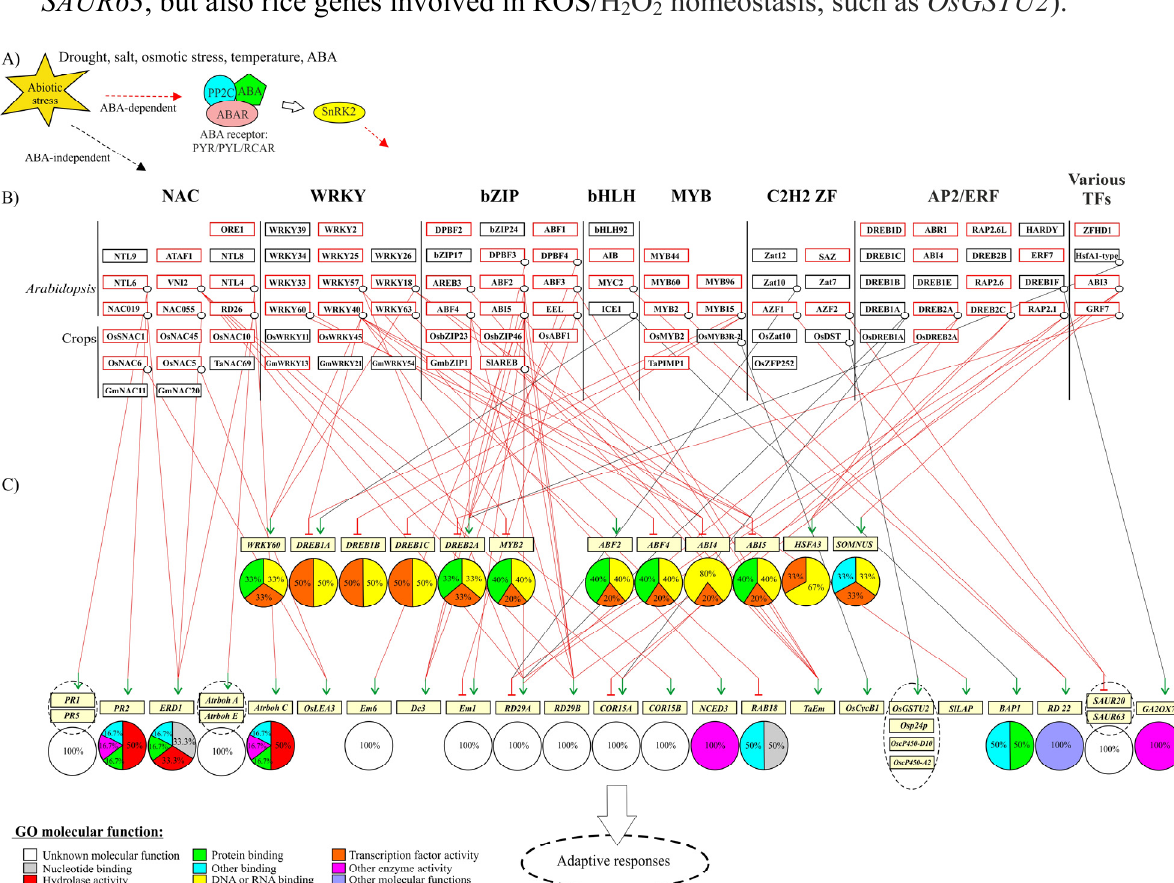
(Figure 1A), TFs known to function in abiotic stress responses (black boxes and lines) and/or ABA-associated signaling (red boxes and lines) (Figure 1B), and their direct target genes (Figure 1C). Figure 1. Gene regulatory networks of plant transcription factors (TFs) in plant abiotic stress responses and abscisic acid-dependent gene expression. ( A ) Drought, salt, osmotic stress, temperature, and ABA stress factors modulating the level and activity of the TF ( B ) and their target genes ( C ). ABA-dependent signaling pathway can involve TF phosphorylation through the PYR/PYL/RCAR ABA receptor [15]. ( B ) The boxes represent TF proteins from the model plant Arabidopsis or from different crop plants. Red boxes and lines show that the TF is associated with ABA-signaling. For TF and target genes with several names only one of the names is shown. For references and abbreviations used see the main text. ( C ) The direct target genes are divided into regulatory genes including TF genes and stress-responsive genes encoding functional proteins. The Gene Ontology (GO) molecular function term is shown as a circle with color code below each Arabidopsis target gene. The GO molecular function annotation was obtained using the Gene Ontology search tool [16] at The Arabidopsis Information Resource. Green arrows and red bars denote TF activation and repression, respectively. Some target genes with no known GO-based molecular function were grouped ( i.e. , PR1 and PR5 , Atrboh A and Atrboh E , SAUR20 and O homeostasis, such as OsGSTU2 SAUR63 , but also rice genes involved in ROS/H 2 2